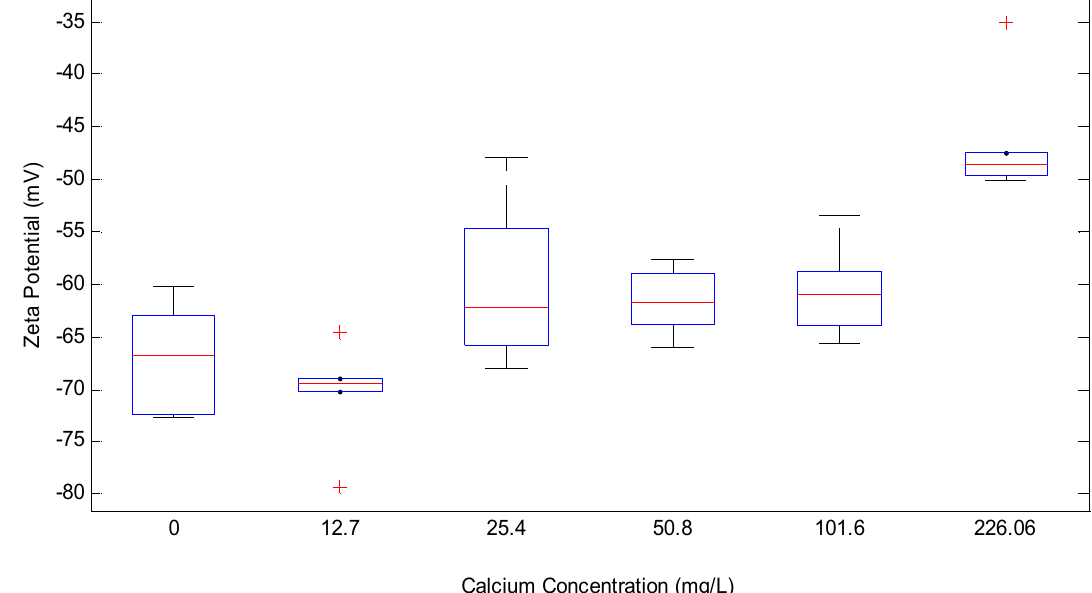
Figure 2. Box plot for change in Zeta potential (mV) with calcium concentration (mg/L) in 1 g/L SA and 2 mM NaHCO 3